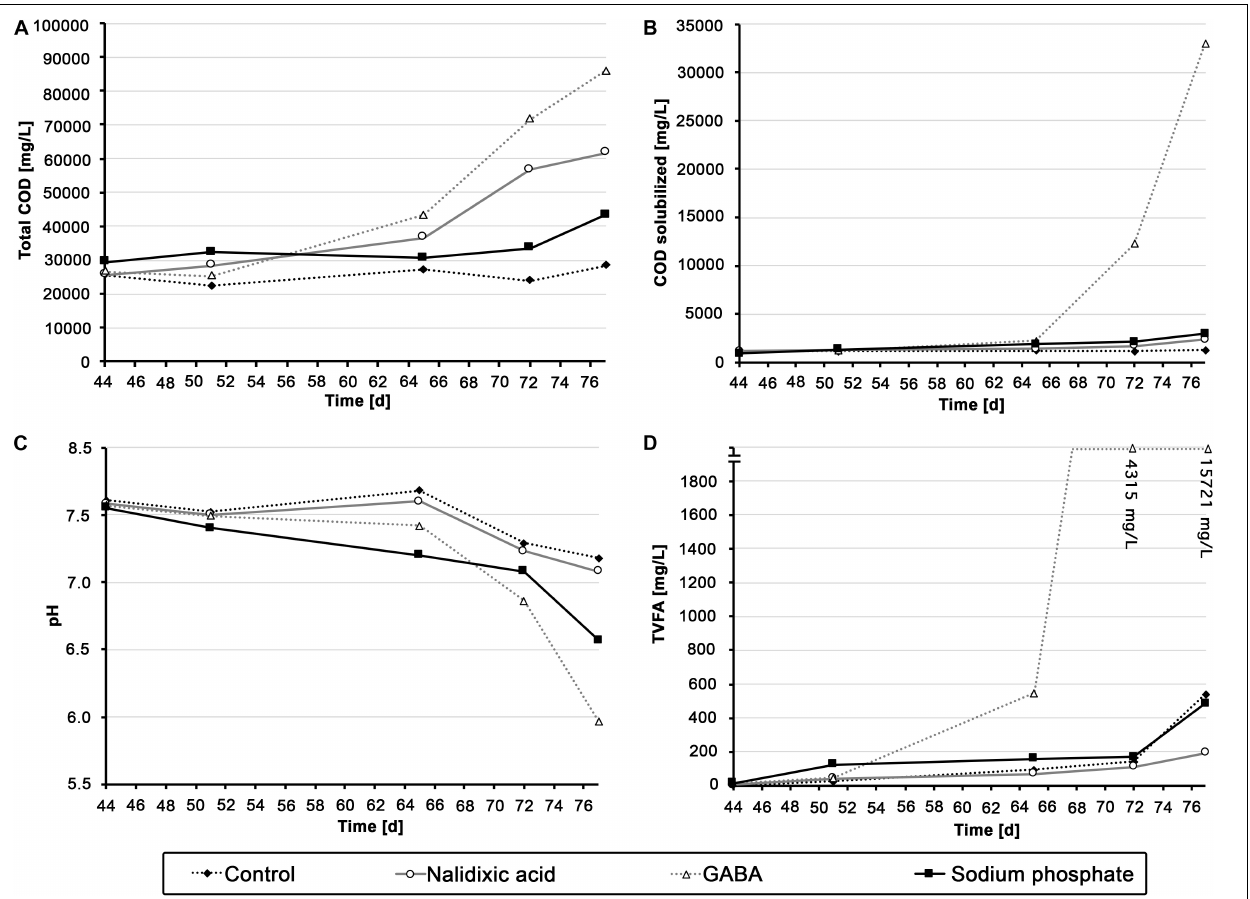
FIGURE 3 | Chemical analysis of the different digesters: Total chemical oxygen demand (A) , solubilized chemical oxygen demand (B) , pH (C) and amount of total volatile fatty acids (D) are shown for all the digester experiments, which were perturbed with nalidixic acid, γ -aminobutyric acid (GABA) and sodium